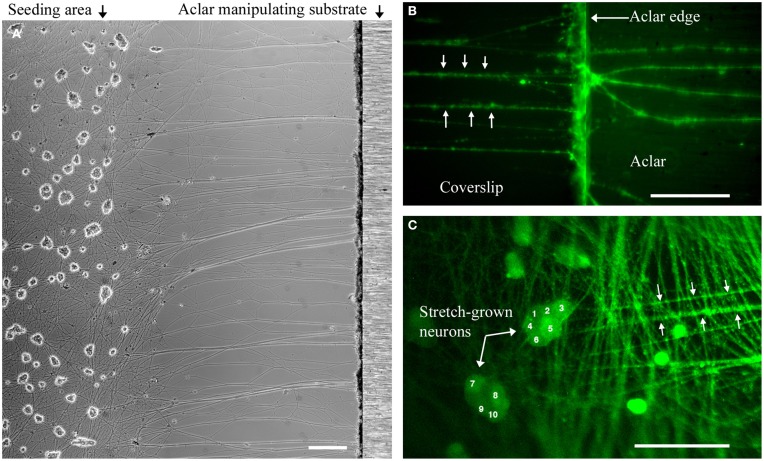
Dissociated stretch-grown neurons. (A) Stretch-grown neurons following 1 mm stretch-growth, bar = 250 μm. (B) Neurons stained with Fluo-4AM were traced from the Aclar manipulating substrate back to the cell seeding area, bar = 50 μm. (C) Cell seeding area containing somata of stretch grown neurons. Bar = 100 μm.